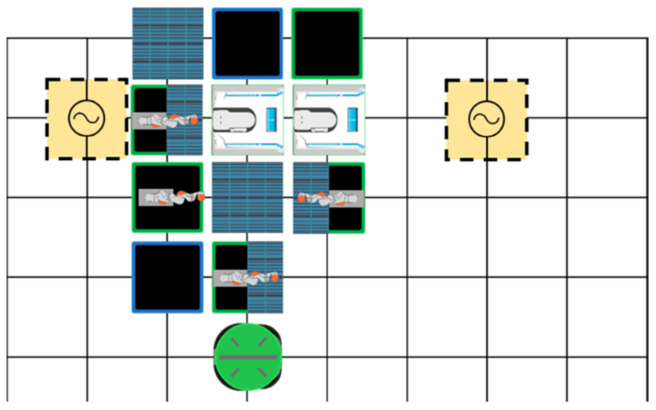
Figure 12. Power supply using fixed power